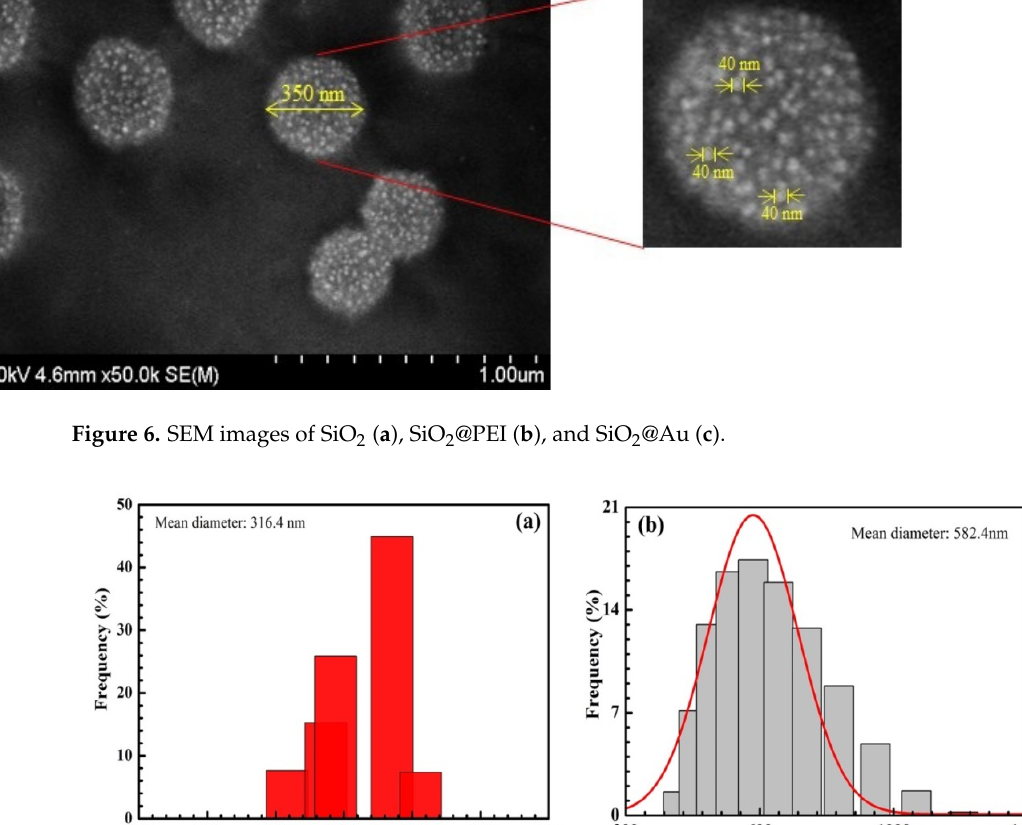
Figure 7. Dynamic Light Scattering results of SiO 2 ( a ) and SiO 2 @Au ( b ).